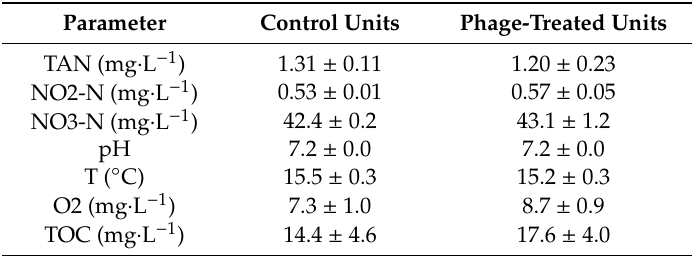
Table 1. Mean ( ± SD) water quality parameters of recirculating aquaculture system (RAS) control units and phage-treated units. TAN = total ammonia nitrogen, NO2-N = Nitrite, NO3-N = Nitrate, TOC = total organic carbon.